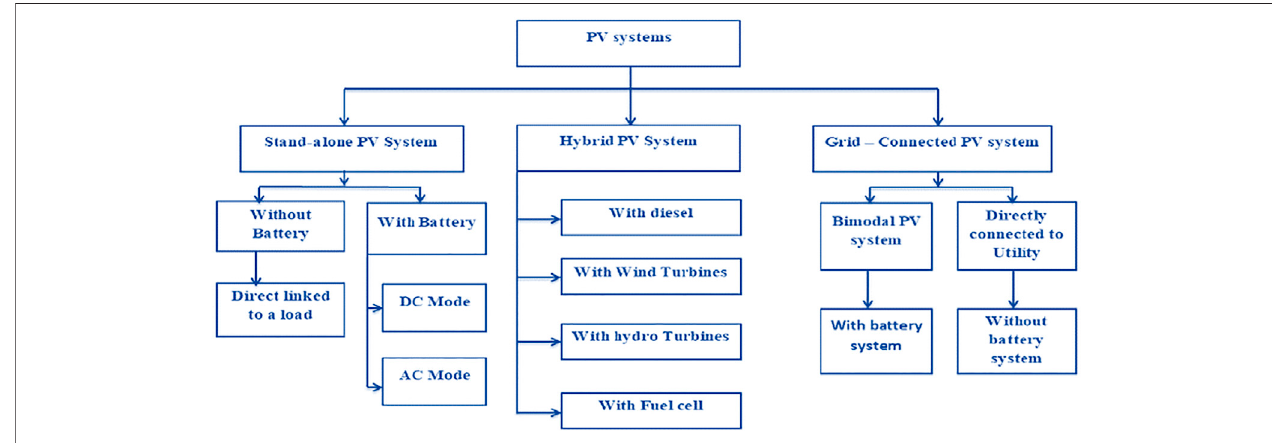
FIGURE 4 | Types of solar photovoltaic systems (Assadeg et al.,